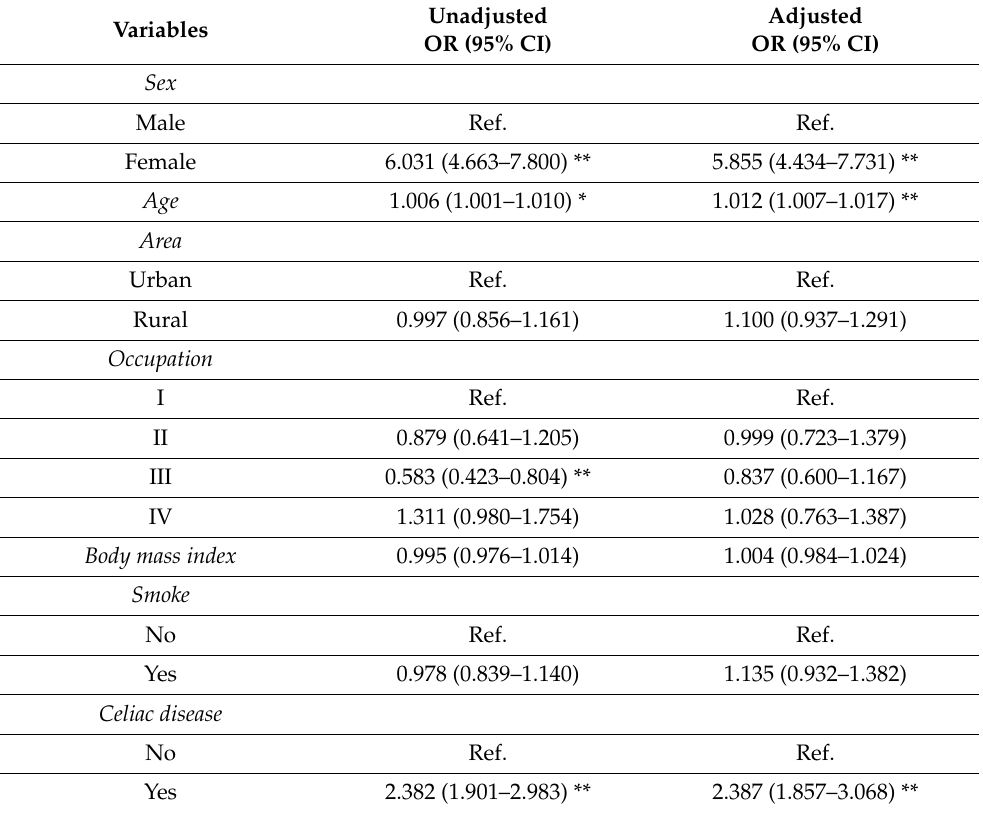
Table 3. Multiple logistic regression for autoimmune thyroid disease (matched with